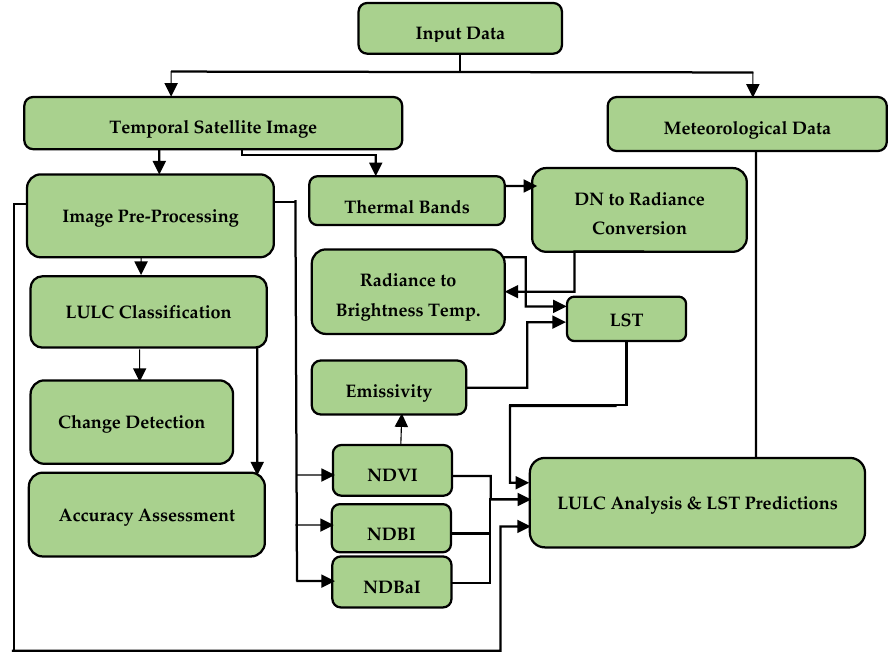
Figure 2. Flow Chart of the Methodology .